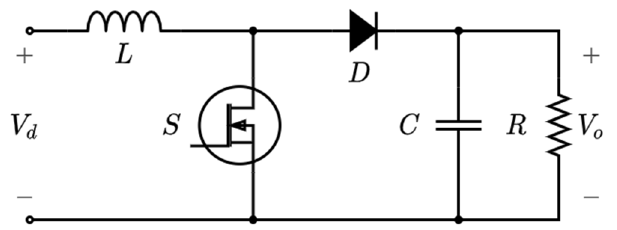
Figure 14. Conventional non-isolated DC/DC boost converter.